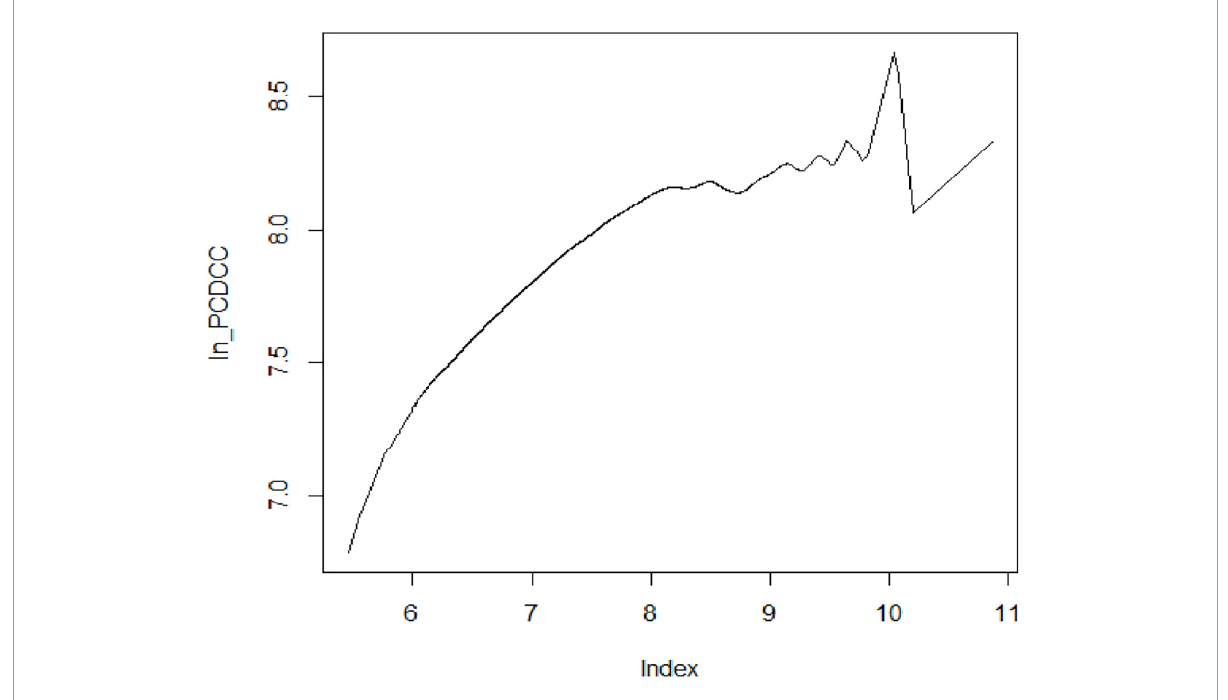
FIGURE3 Semi-parametric single-index estimation of calorie–income relationship.